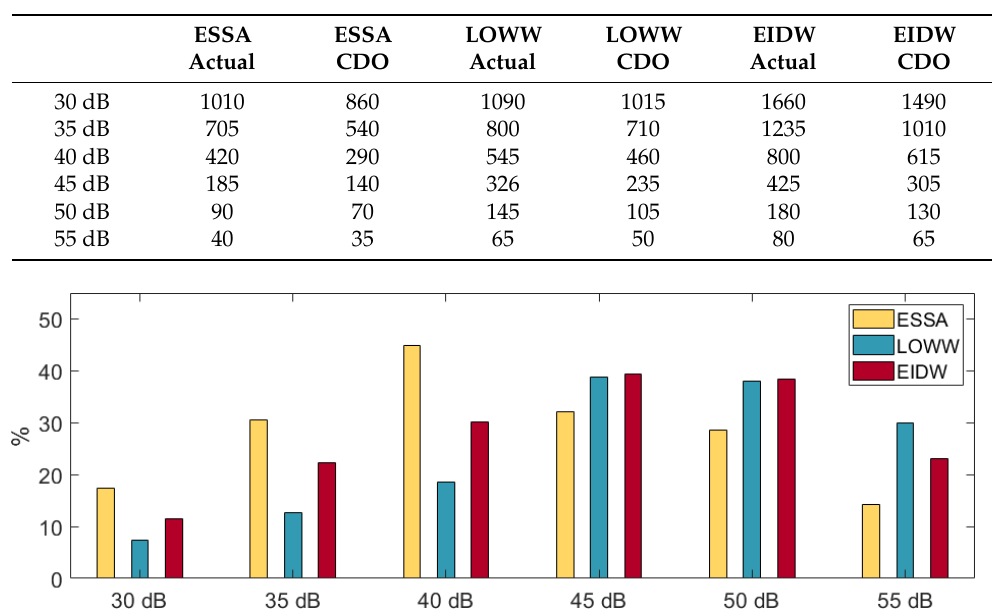
Figure 6. Noise contours ( L den ) ranging from 30 to 90 dB for actual arrival trajectories ( a ) and CDO trajectories ( b ) for the Dublin airport TT dataset in October 2019. Table 2. Size of areas, expressed in km 2 , exposed to different noise levels, for actual trajectories compared to CDO.